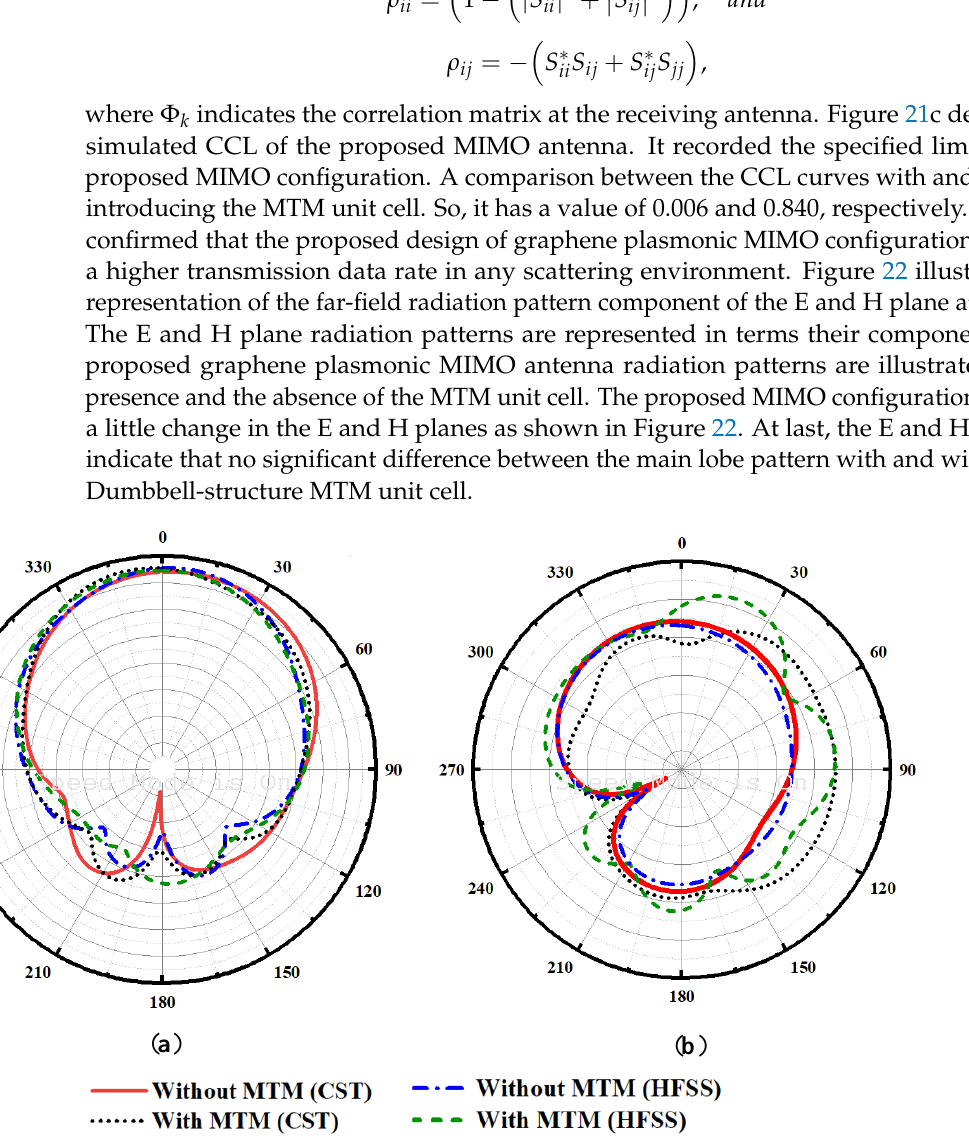
Figure 22. Far-field radiation of Ant. C with and without MTM unit cell ( a ) E-plane and ( b ) H-Plane.